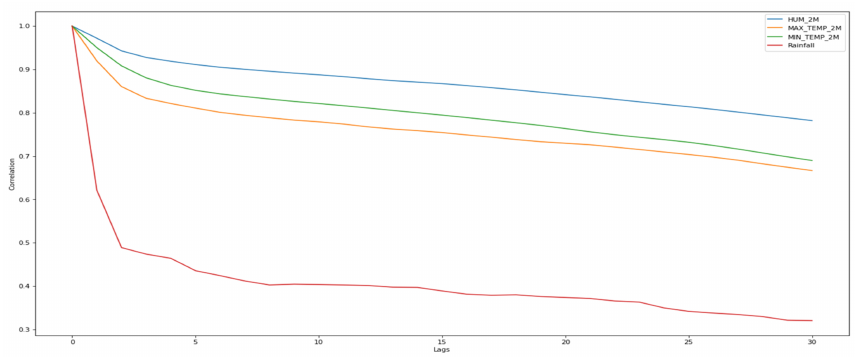
Figure 13. Autocorrelation summary for Relative Humidity, Maximum Temperature, Minimum Temperature and Rainfall.